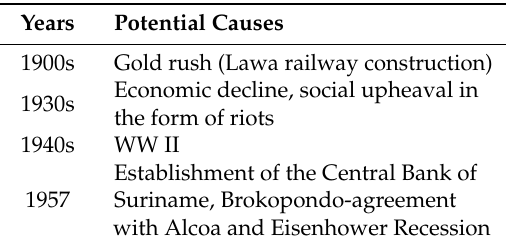
Table 5. Estimated historical episodes with high inflation.